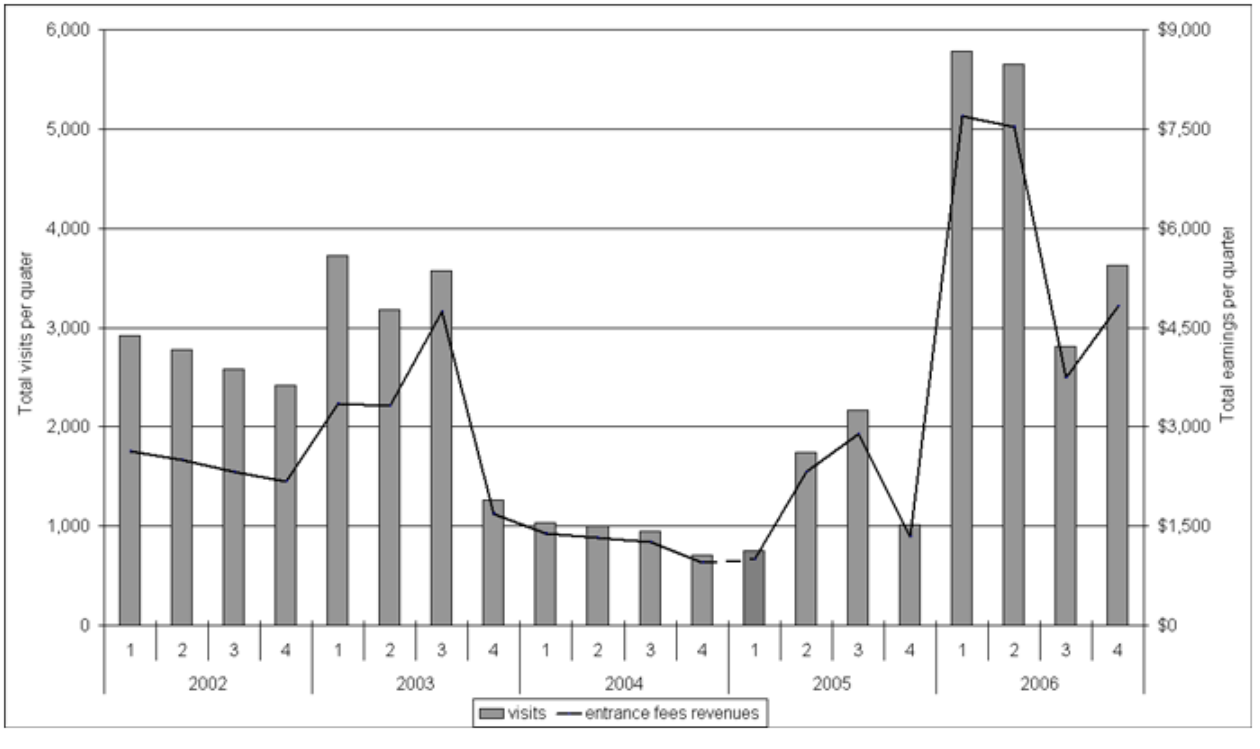
Fig. 4. Total tourist visits and entrance fee revenues at OMYK from 2002 to